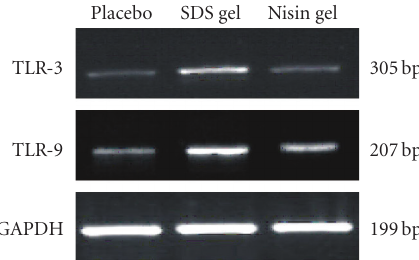
Figure 3: RT-PCR analysis of TLR- 3 and 9 expression. Total RNA was extracted from CVE cells and subjected to RT-PCR analysis as described in the Material and Methods. No change in TLR gene expression was observed in nisin administered animals compared to placebo gel-treated group. However, in SDS gel administered animals, the expression of TLR genes was upregulated. House keeping gene, GAPDH expression confirms roughly equivalent loading of RNA